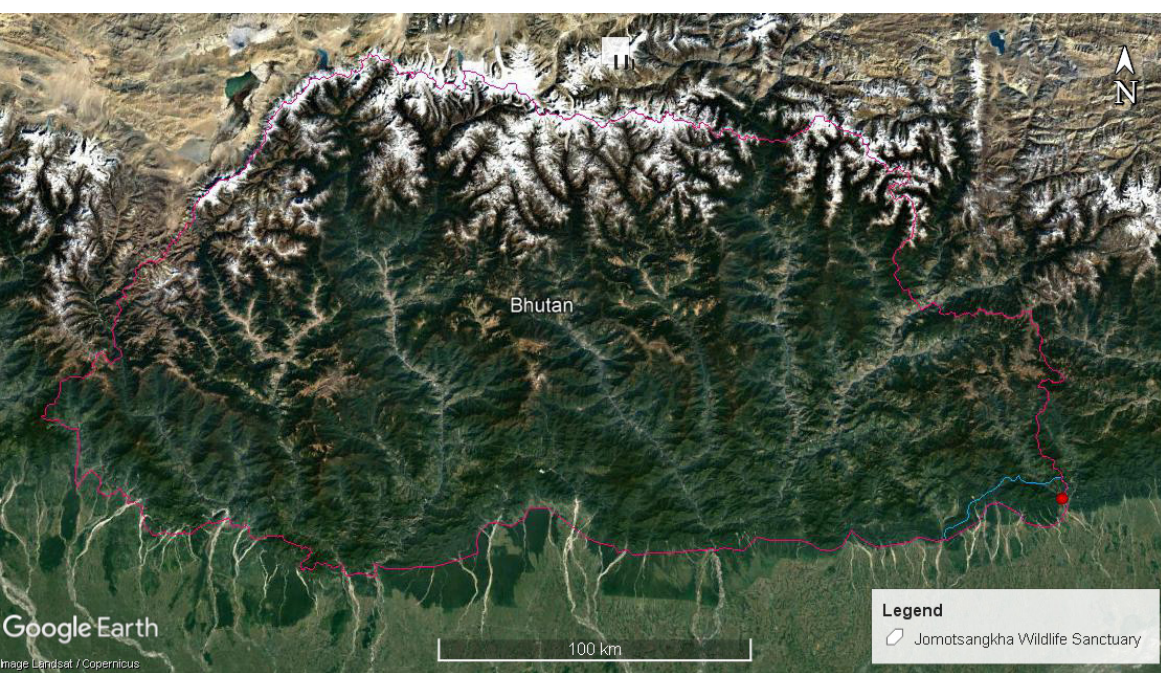
Figure 1. Bhutan map showing record place of Boiga quincunciata.